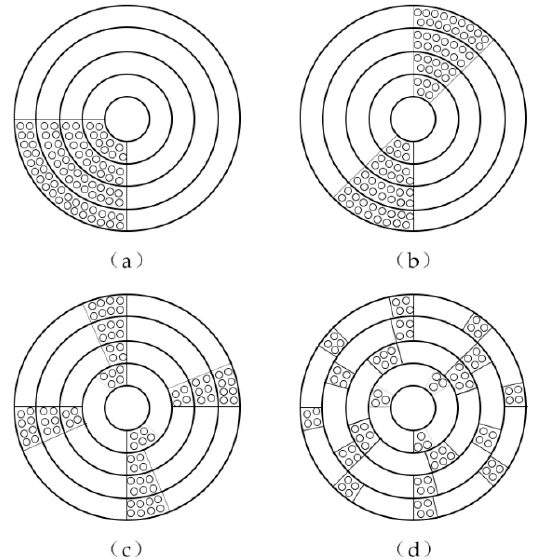
Figure 3. Adsorbent distribution of four experimental conditions ( a )–( d ).